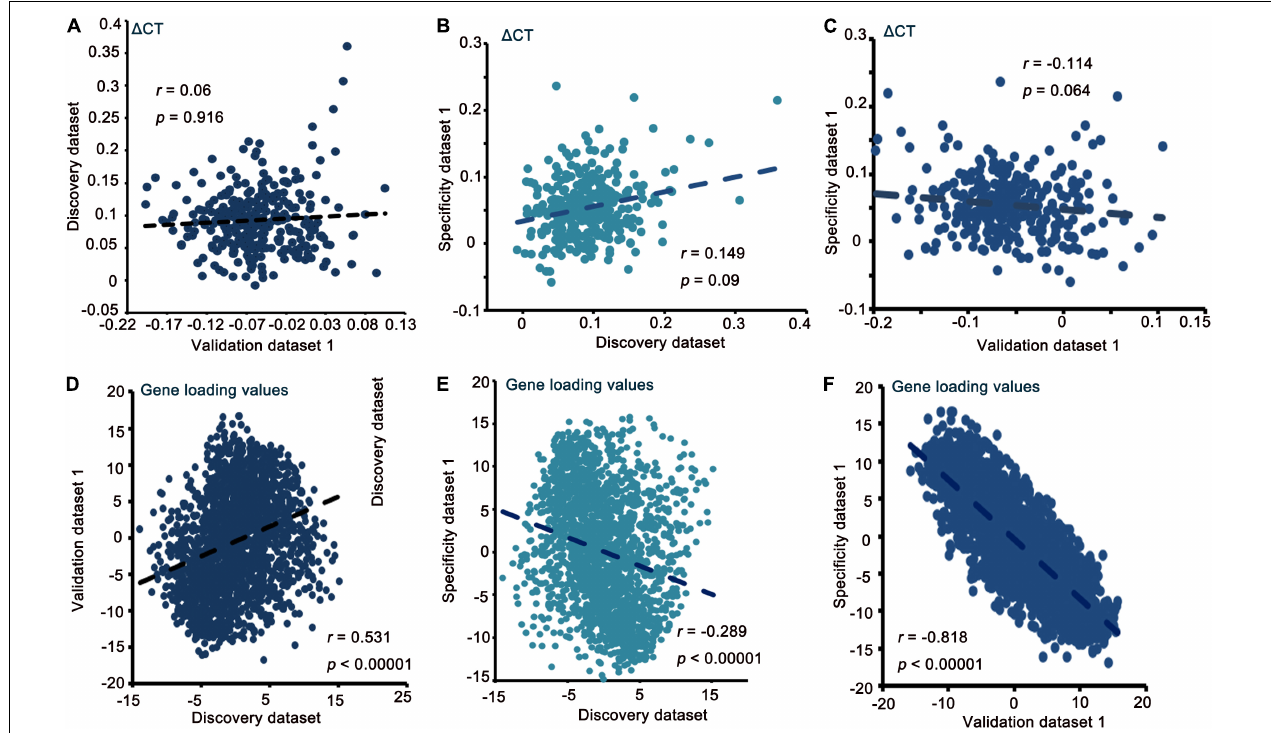
FIGURE 2 | Correlation of (cid:49) CT and gene loading value between the discovery, validation, and specificity datasets (A–F) .